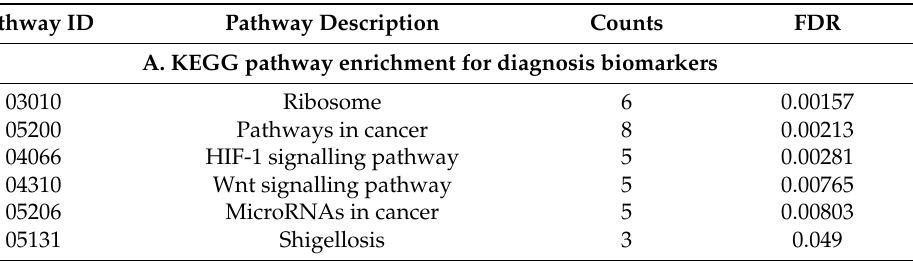
Table 1. KEGG pathway enrichment results for CRC protein biomarkers.